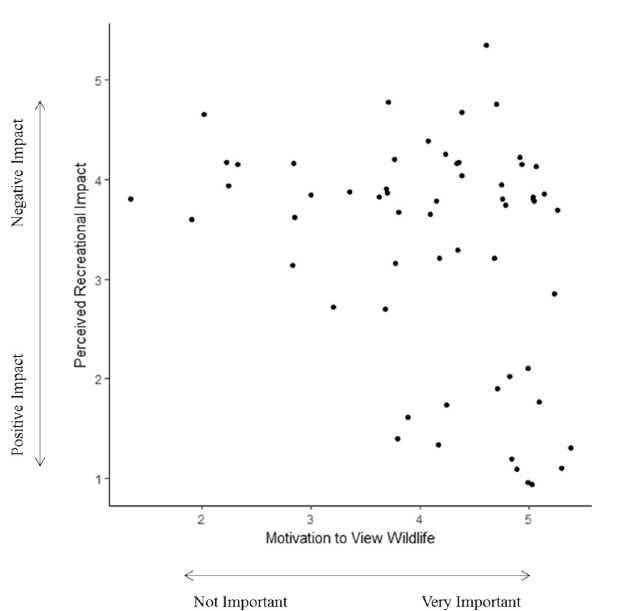
Figure 3. Ordinal rankings of perceived recreational impact to wildlife (1 = Positive, 3 = No impact, 5 = Negative) compared to motivation to view wildlife (1 = Not Important, 3 = Neutral, 5 = Very important) (n = 59). There is a negative correlation between viewing wildlife and perceived recreational